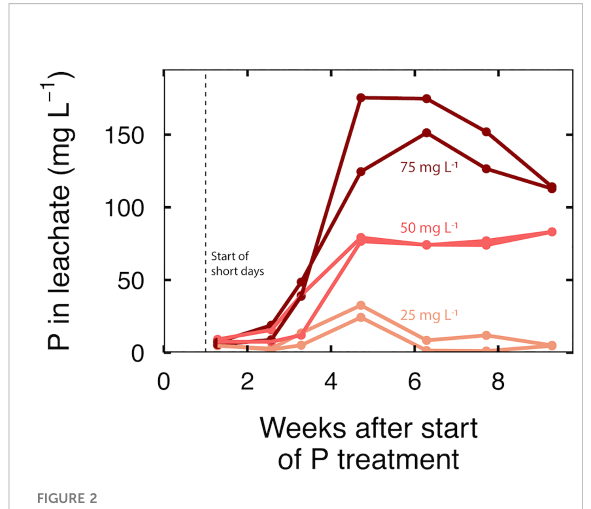
FIGURE 2 Time series of P in the leachate at an input P of 25, 50 and 75 mg per L. Each line represents a sample taken from a leachate collection tray that contained three separate